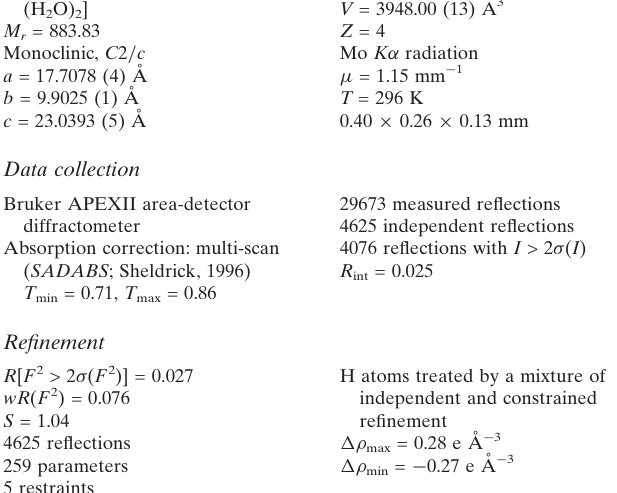
Data collection Bruker APEXII area-detector diffractometer Absorption correction: multi-scan ( SADABS ; Sheldrick, 1996) T min = 0.71, T max = 0.86